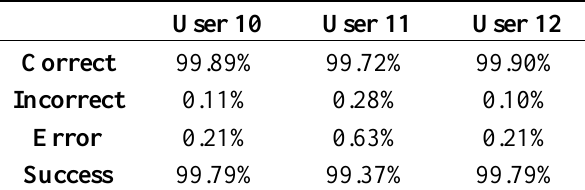
Table 19. Average of annoying sounds II.